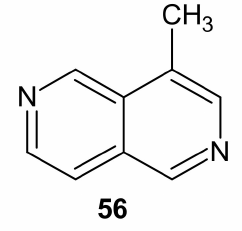
Figure 17. 4-Methyl-2,6-naphthyridine 56